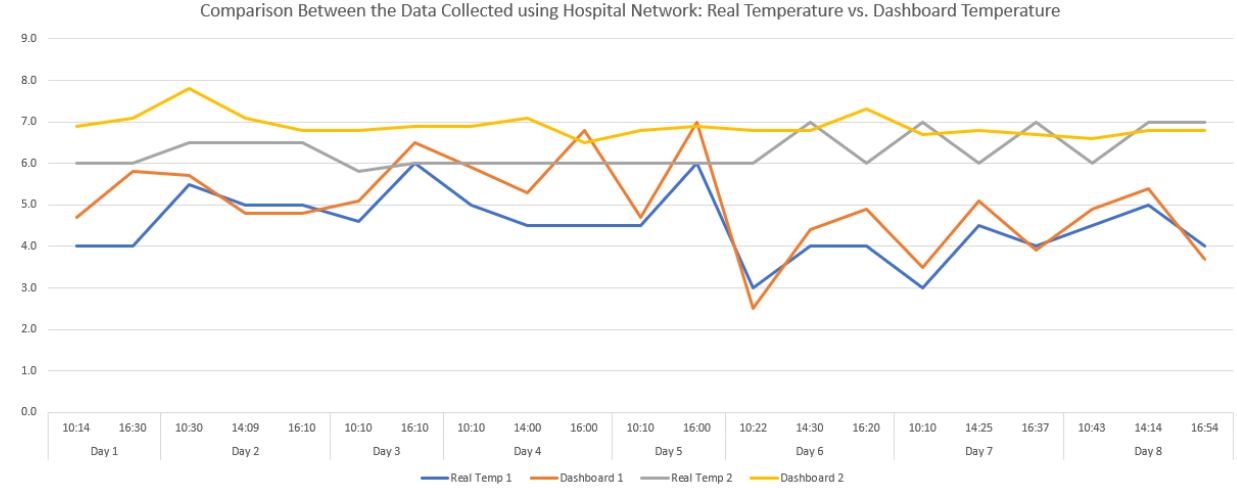
Figure 11. Comparison Between the Data Collected using Hospital Network in Chart.